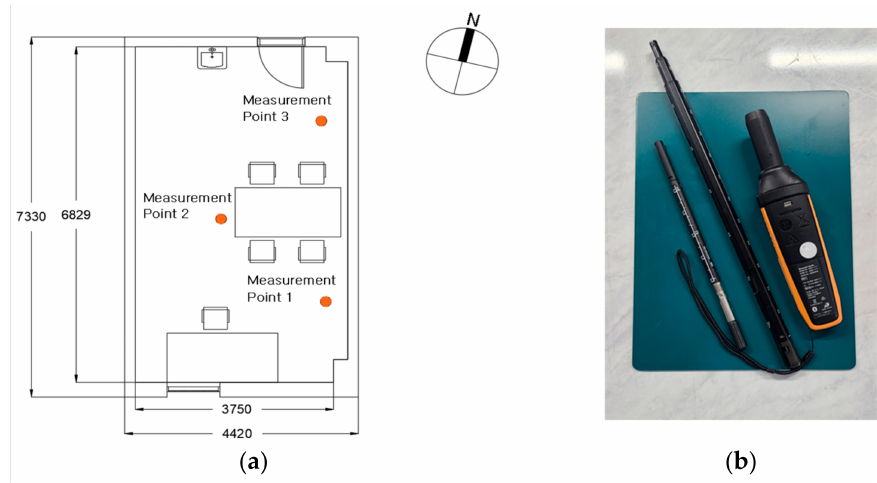
Figure 14. ( a ) Indoor air quality test measurement locations in a single-person office space where a validation experiment for the simple diagnostic program was conducted and ( b ) wind speed measurement device.